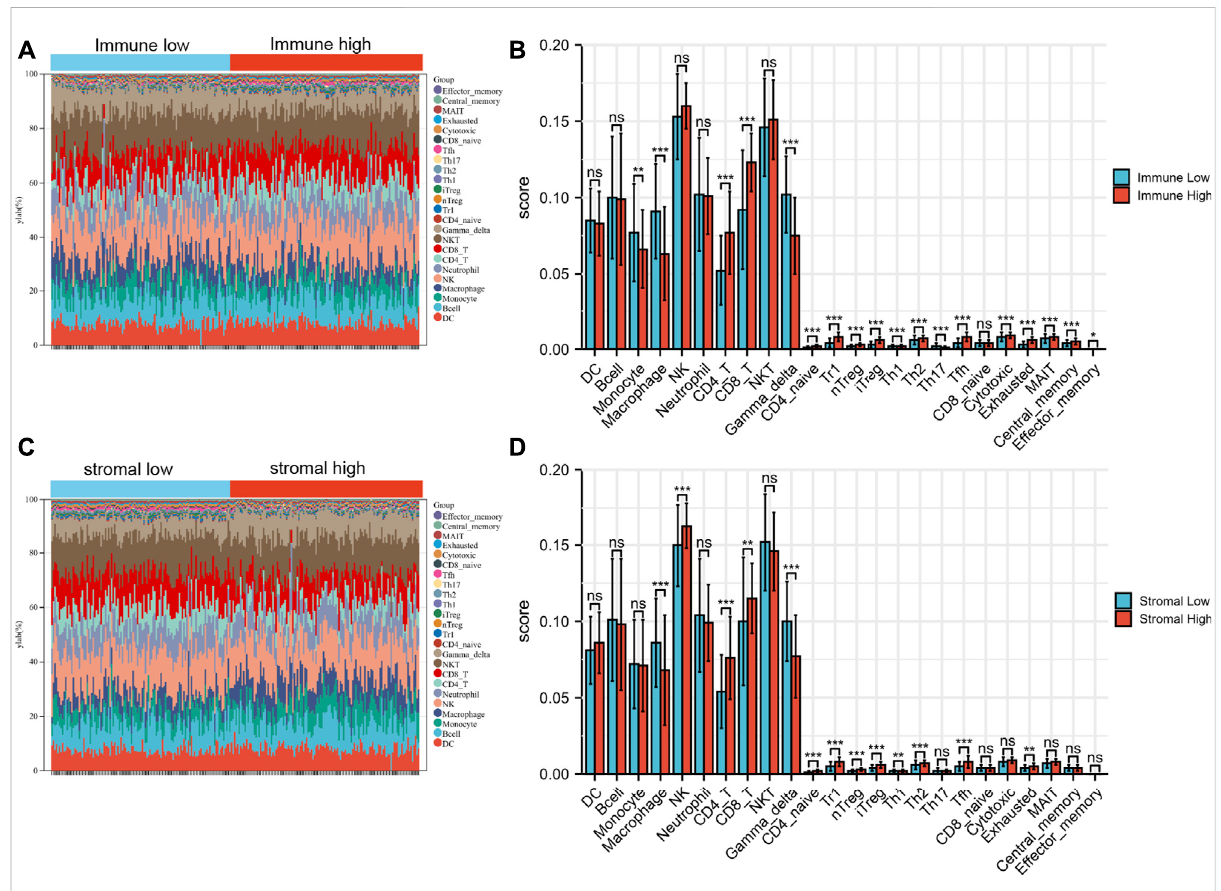
FIGURE 8 The immune landscape of BRAF mutated samples microenvironment. (A) The landscape of immune cells among immune high and low group. (B) Immunecelldifferencesbetweenimmunehighandlowgroup. (C) Thelandscapeofimmunecellsamongstromalhighandlowgroup. (D) Immune cell differences between stromal high and low group. * p < 0.05; ** p < 0.01; *** p <